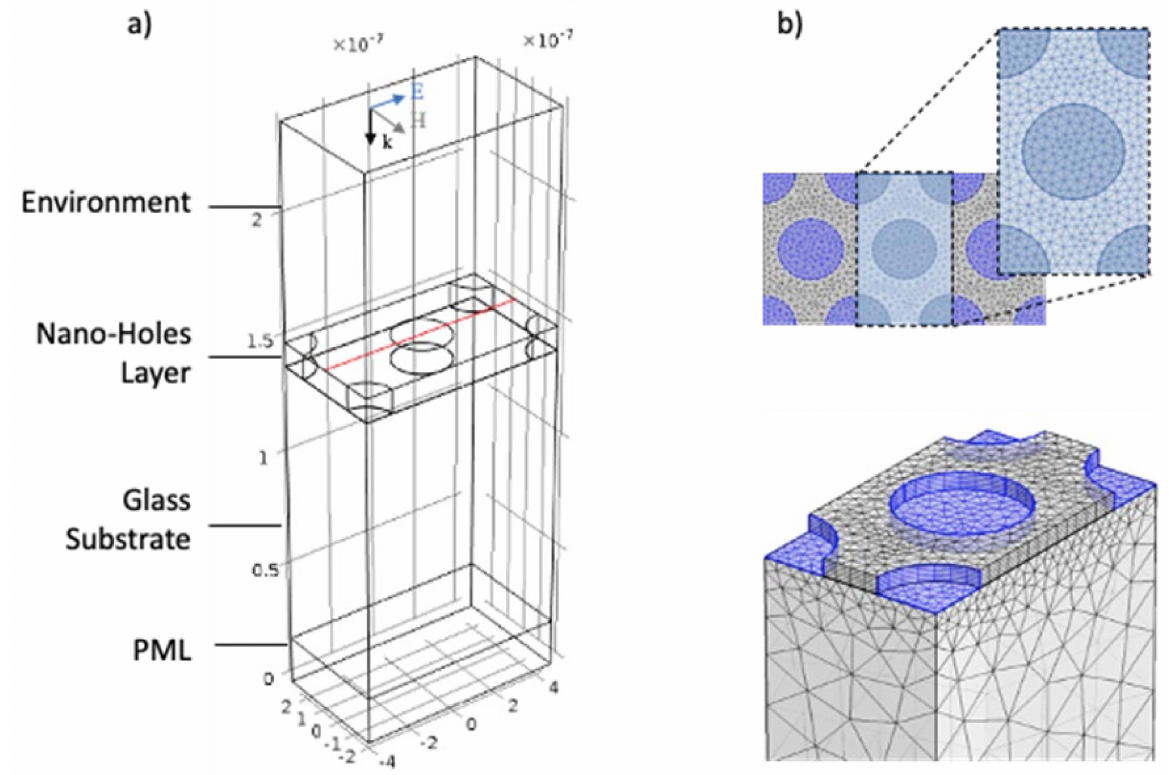
Figure 4. ( a ) Sketch of the geometry of the computational domain adopted in the numerical sim- ulations; from the bottom: a perfect matched layer (PML), glass substrate, gold nano-holes and environment. ( b ) Representation of the unit which simulates the fabricated nano-structures: a free triangular mesh, utilized for the glass substrate and the environment, and a swept mesh, chosen for the nano-structure and the PML, are